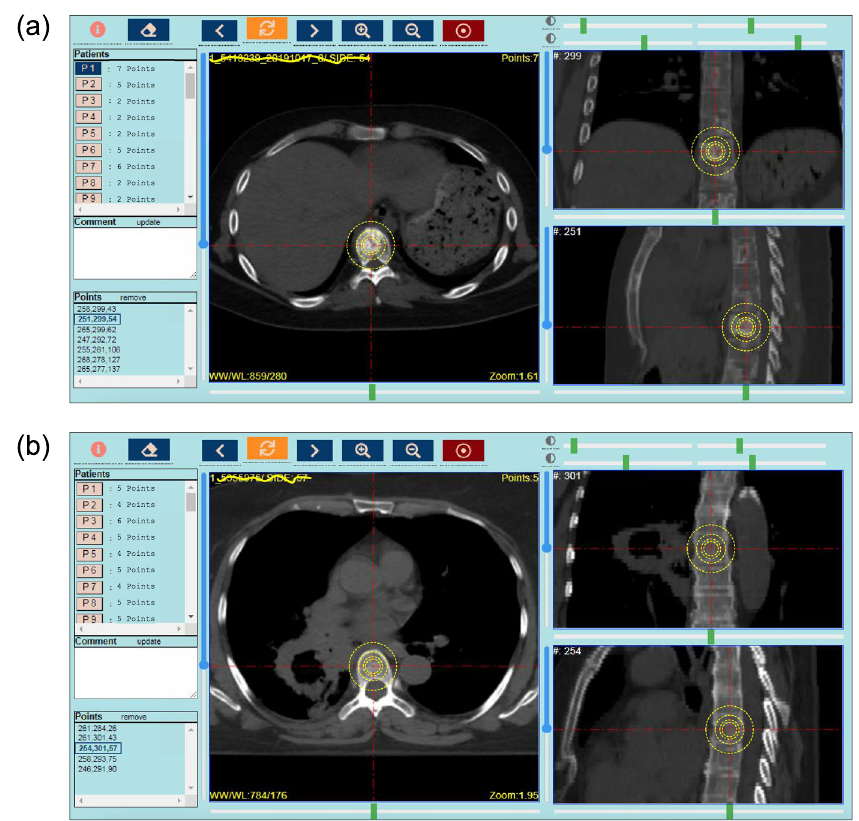
Figure 2. Screenshots of our diCOMBINE 3D lesion labeling web application showing expert-labeled points. ( a ) A BM lesion, and ( b ) a HB point. Cross sections of 50 mm, 30 mm, 20 mm, and 15 mm spherical ROIs are visualized with yellow dashed lines on each CT